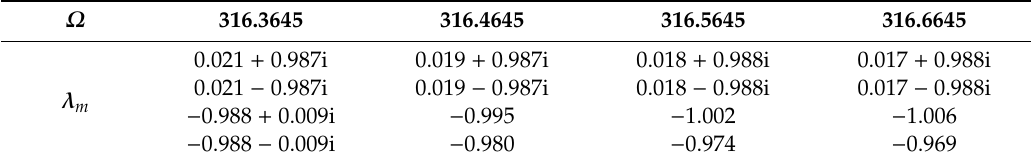
Figure 5. For δ 0 = 1.5 μ m, response characteristics of the VC period-2 motion when Ω = 330 rad/s, ( a ) orbit (black line) and its Poincare mapping (red dots), ( b ) time series and their frequency spectra. Table 2. Period-1 motion Floquet multipliers λ m around A 1 .